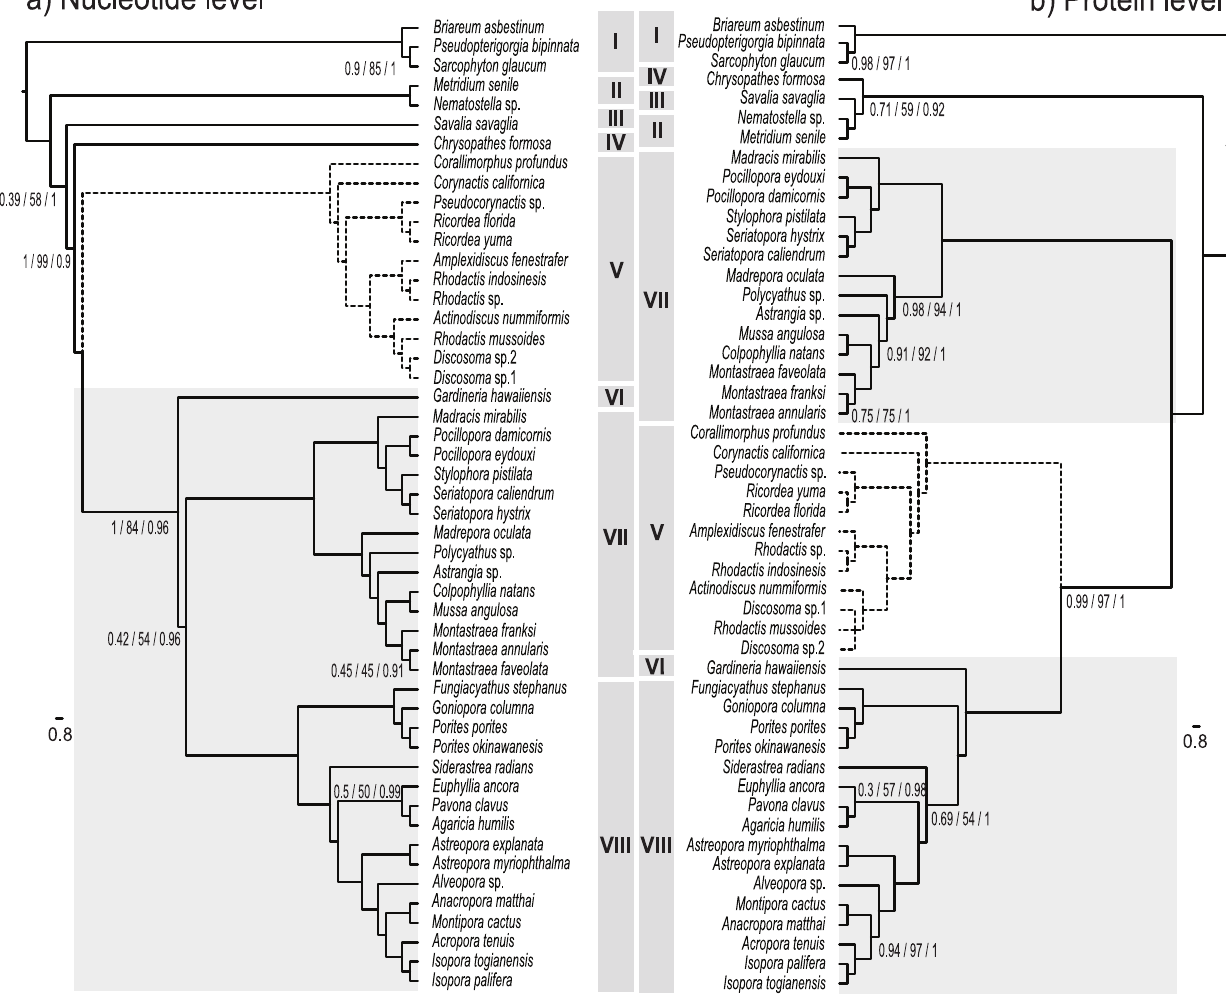
Figure 3. Phylogenetic analyses based on (a) the nucleotide sequences of the mitochondrial genes encoding proteins and (b) the amino acid sequences of the proteins encoded by the mitochondrial genomes. Values on the nodes indicate the non-parametric SH test and bootstrap replicates (ML), and posterior probability (BI) support respectively. Where no values are shown on a node, that edge was fully supported under all analyses. Dashed lines indicate the corallimorpharian clade. Light grey blocks identify the scleractinian clades. (I) Octocorallia used as outgroup; (II) Actiniaria; (III) Zoanthidea; (IV) Antipatharia; (V) Corallimorpharia; (VI) ‘‘Basal’’ Scleractinia; (VII) ‘‘Robust’’ Scleractinia; (VIII) ‘‘Complex’’